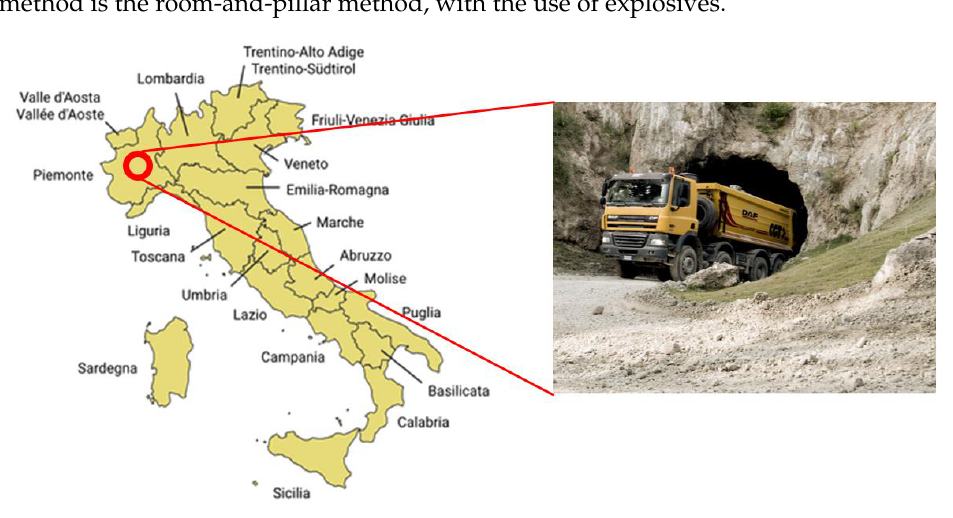
Figure 1. Geographical location of the Murisengo Underground Quarry in the Piedmont Region of the northwest of Italy. the northwest of